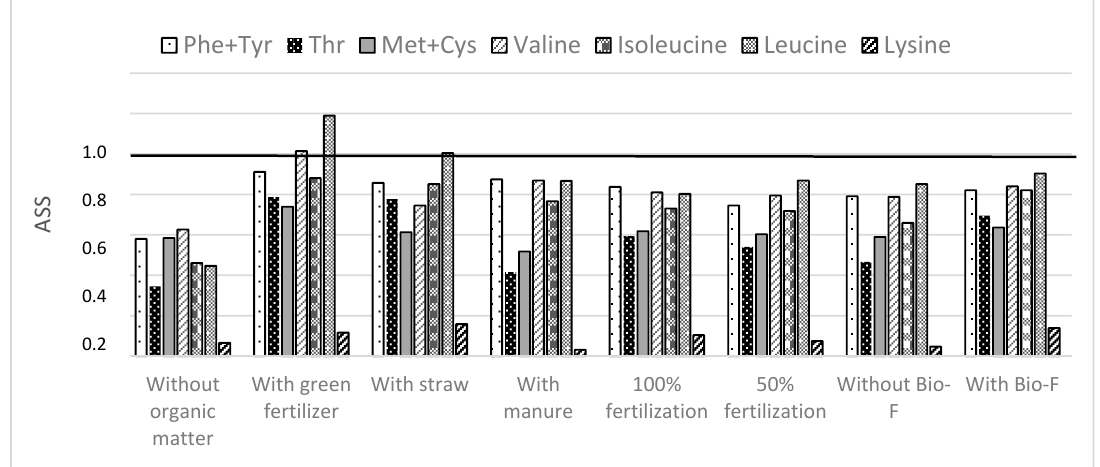
Figure 2. The ASS of the potato tubers as affected by organic, mineral and bio fertilization studied. WHO/FAO adult maintenance pattern expressed as g amino acid/100 g protein: Phe +Tyr, 3.8; Met + Cys, 2.7; Lys, 4.5; Thr, 2.3; Leu, 5.9; Val, 3.9; Ile, 3.0; His, 1.5 (WHO/FAO, 2007).